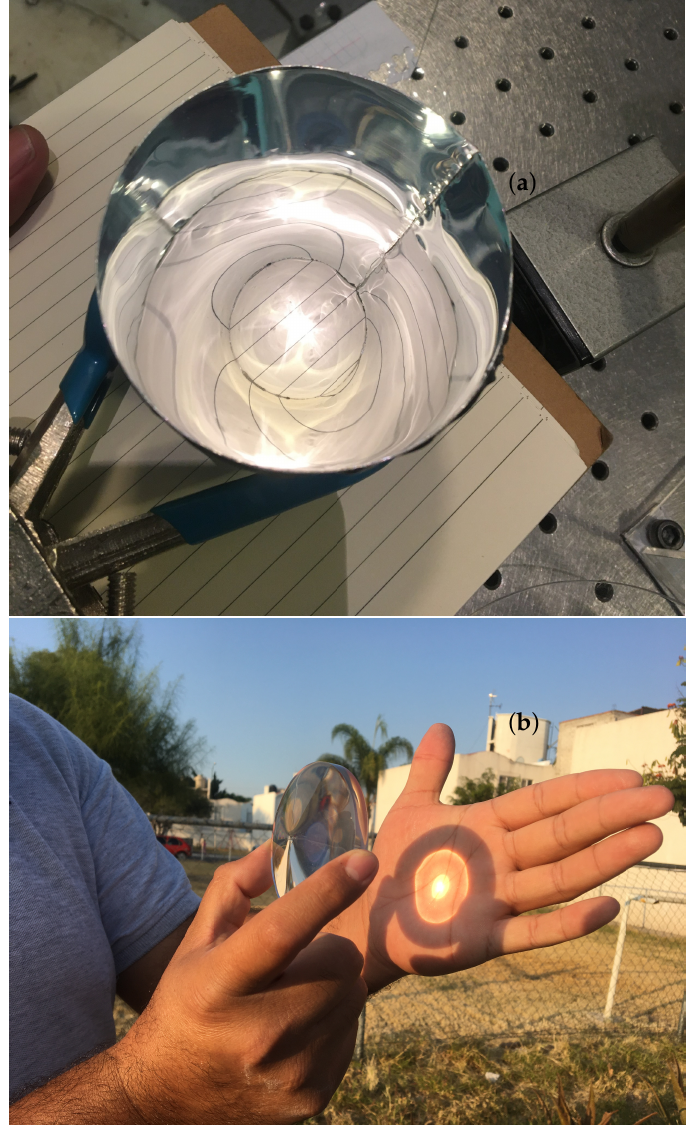
Figure 4. ( a ) Upper view of the funnel and concentration pattern, ( b ) Image of the prism and concentration